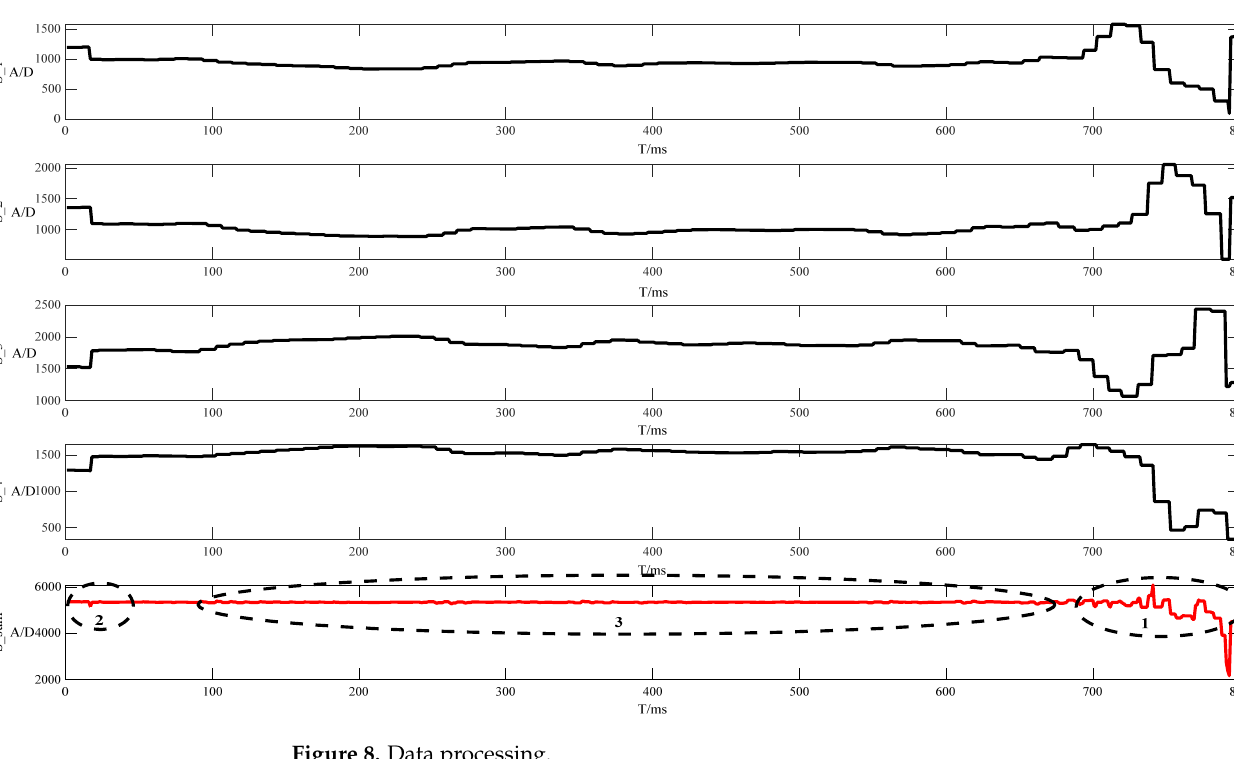
Figure 8. Data processing. Figure 8. Data